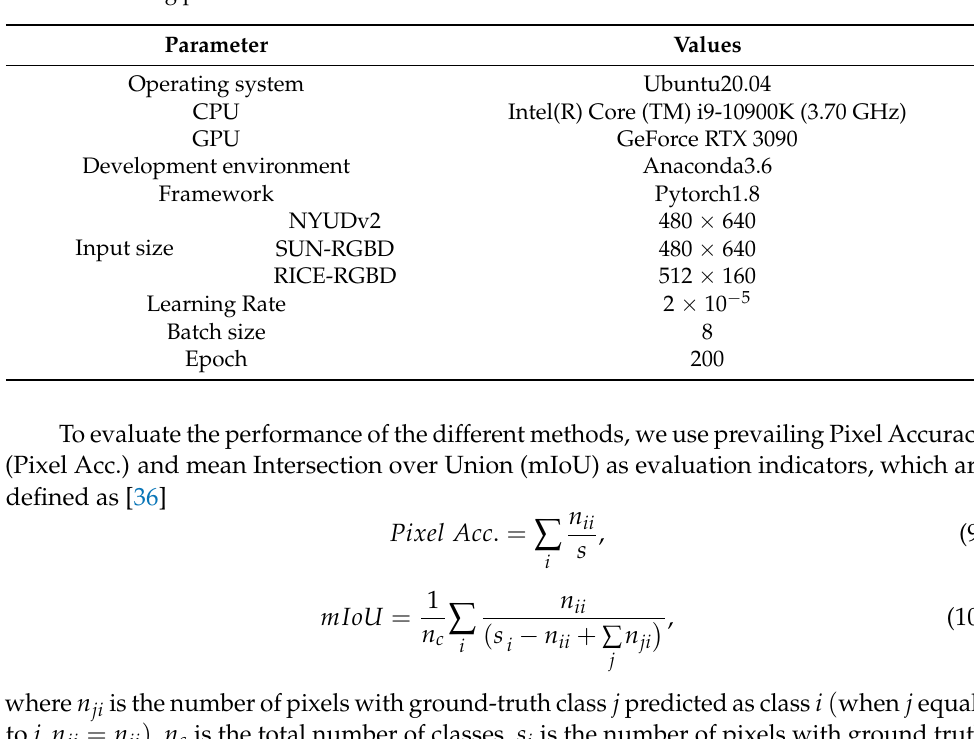
Table 1. Running parameter